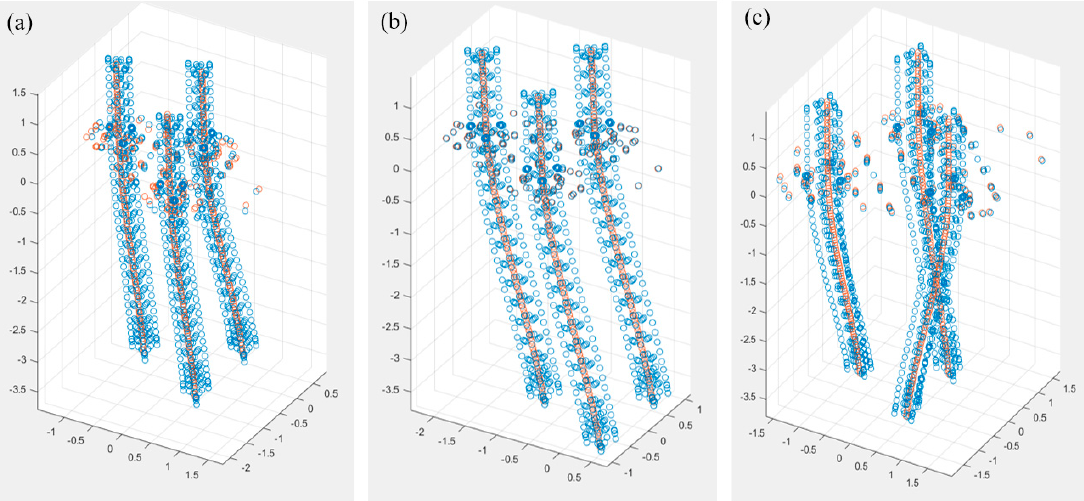
Figure 5. Comparison of mode shapes between stick model and full-order FE model (enlarged by 100 times): ( a ) first mode shape, ( b ) second mode shape, and ( c ) third mode shape. Table 3. Natural frequencies of the SEU from stick model and full-order model (unit: Hz).